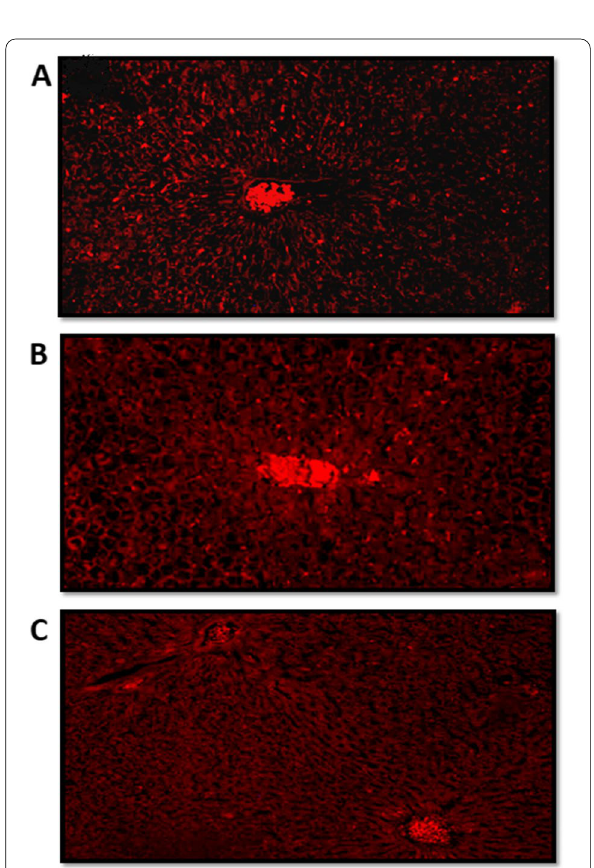
Fig. 2 Fluorescence microscopic study of the liver showing MSCs labeled with PKH26 fluorescent dye in and around central vein in A and B and central vein adjacent portal tract C ; confirming that cells can homing into the liver tissue ( ×